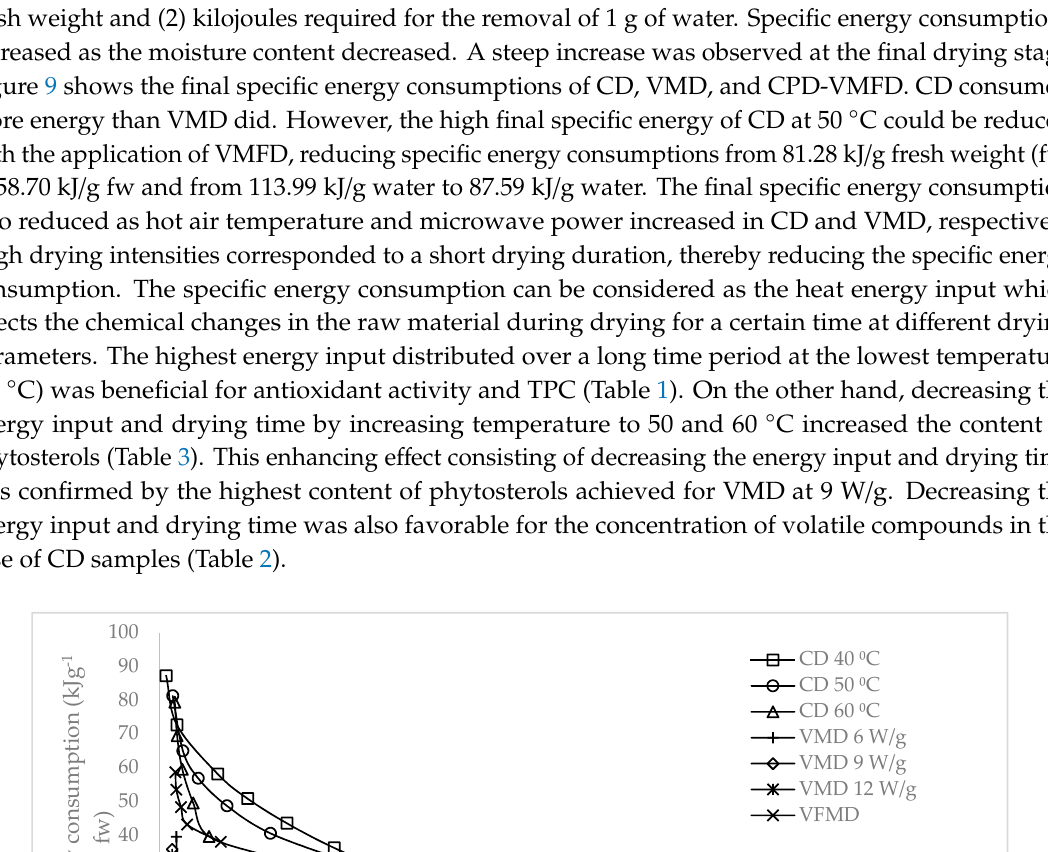
Figure 8. Specific energy consumption of S. crispus leaves per gram of water evaporated using CD, VMD, and CPD-VMFD.